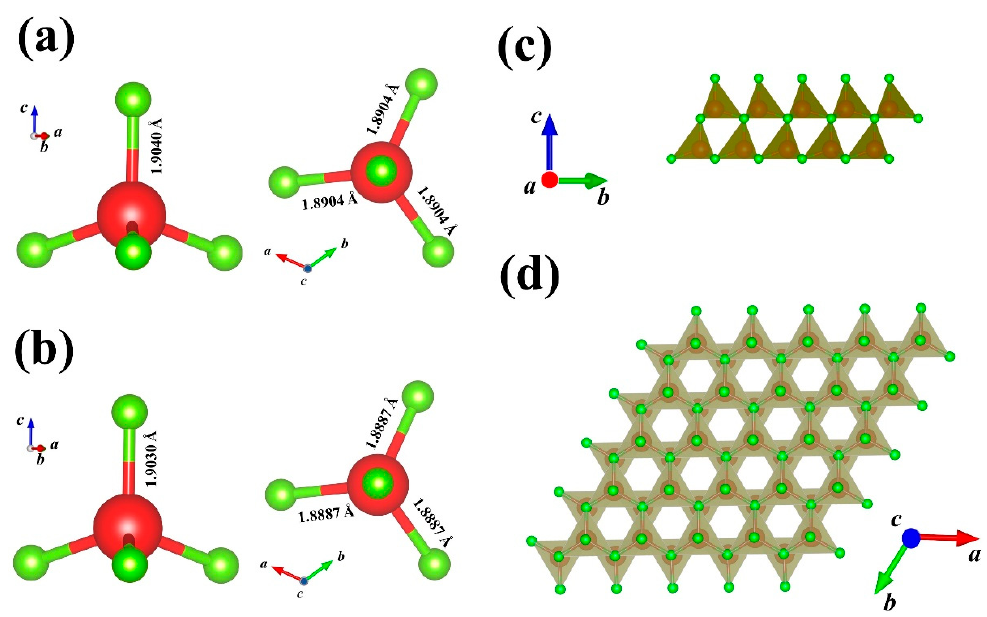
Figure 3. The molecular structure of the seeds of c-plane ( a ) and m-plane ( b ), and the crystal structure at different viewing angles ( c , d ).